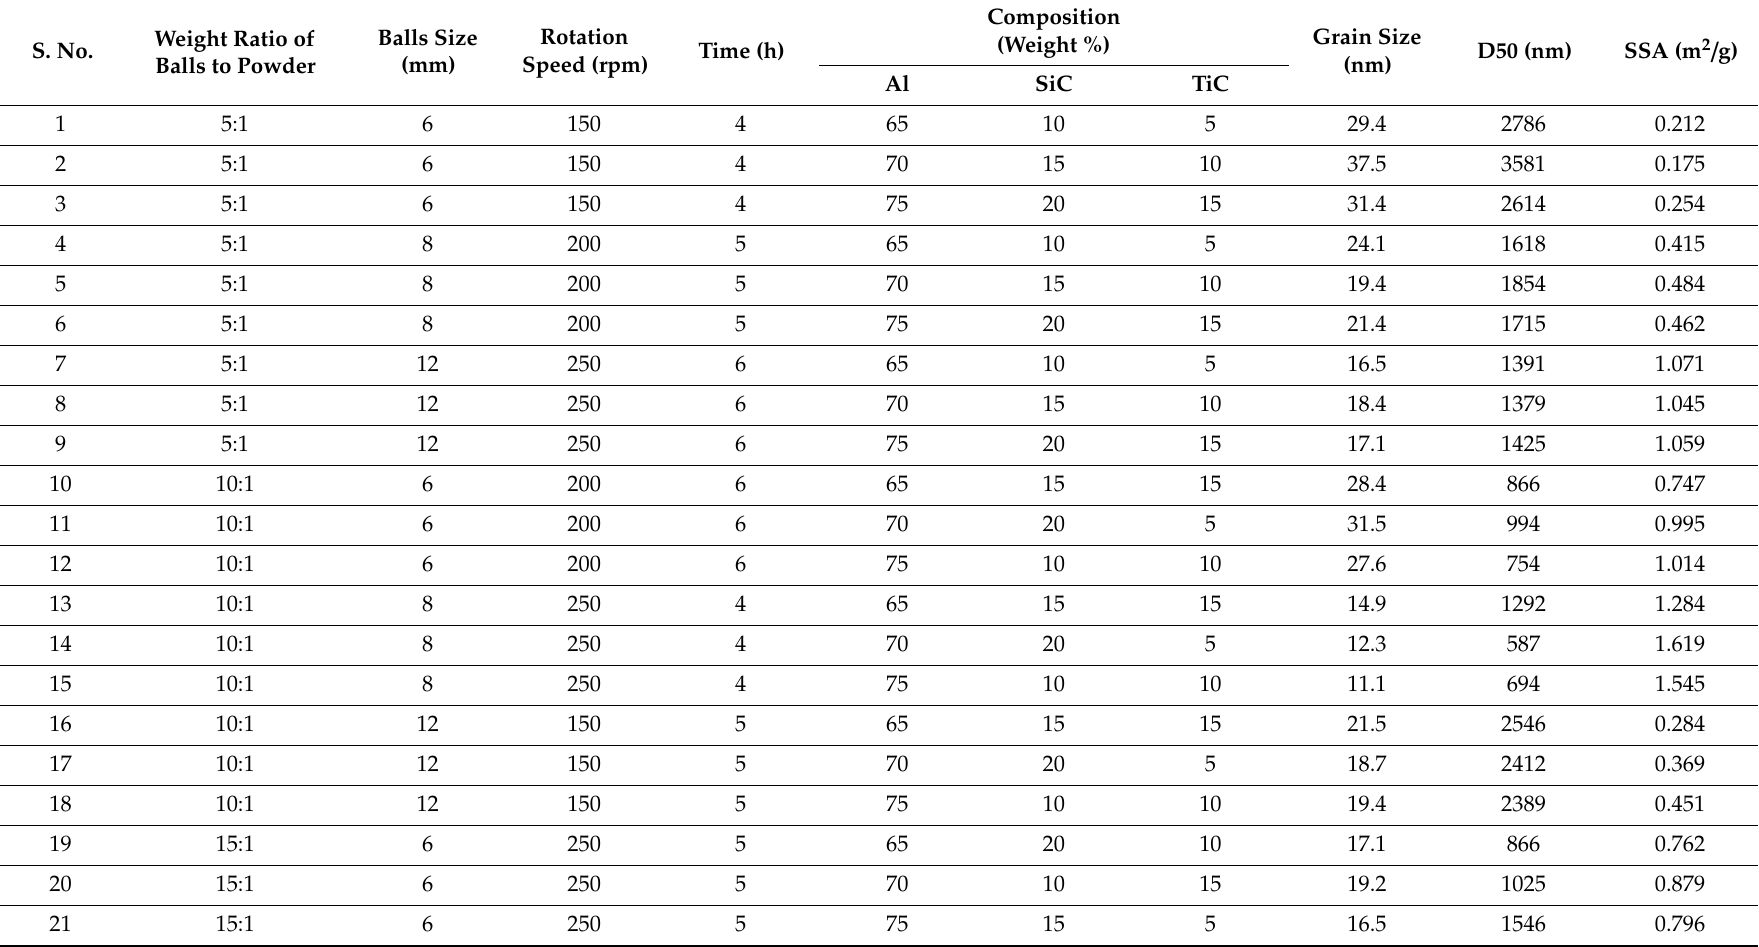
Table 3. L 27 orthogonal array for the ball milling